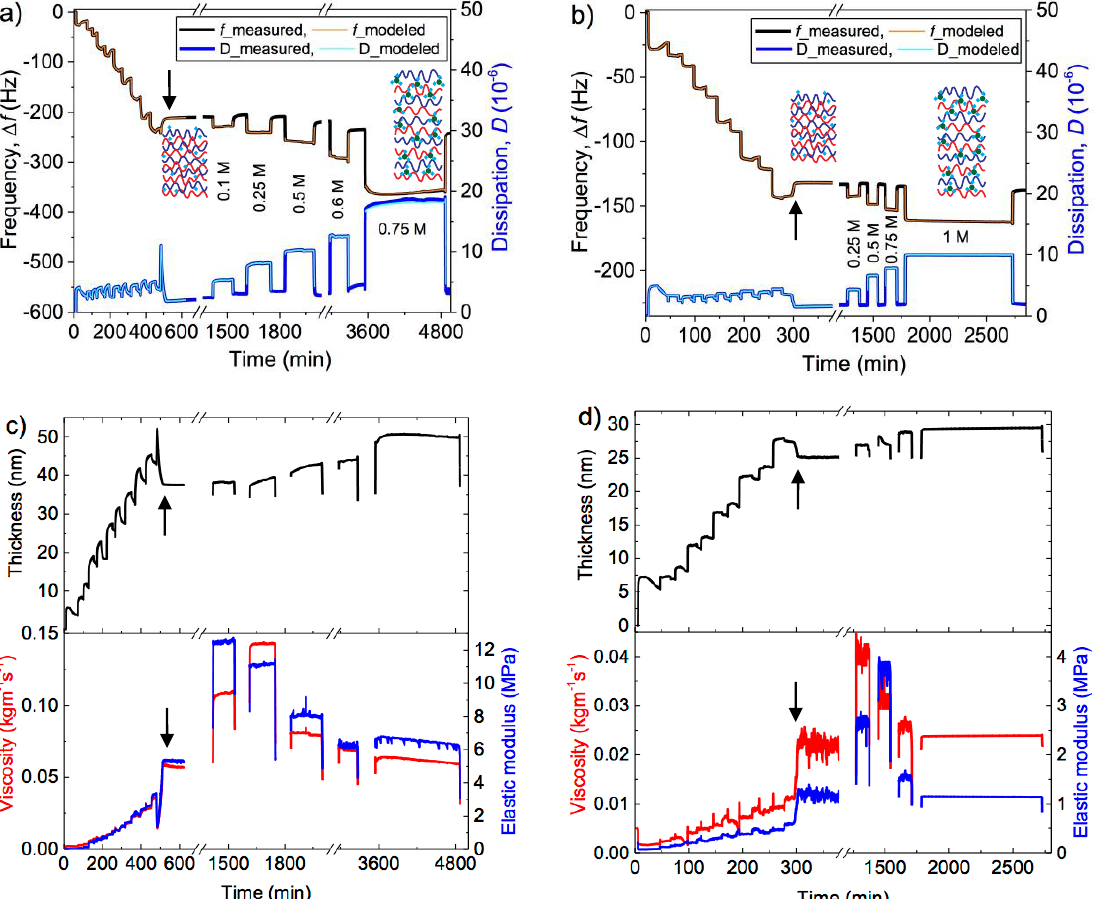
Figure 2. Measured and modeled QCM-D frequency and dissipation shift (7th overtone) upon assembly of ( a ) PEI(PSS/PDADMAC) 4 PSS and ( b ) PEI(PSS/PAH) 4 PSS and their subsequent swelling with the EMIM solution at the EMIM concentrations indicated. Modeled thickness, viscosity and elastic modulus upon layer assembly and subsequent swelling of ( c ) PEI(PSS/PDADMAC) 4 PSS and ( d ) PEI(PSS/PAH) 4 PSS multilayers. The arrows indicate the end of the assembly, where flushing with pure water was performed, followed by the salt swelling cycles. Note that only one representative overtone is displayed, while 5 different overtones were employed in a global fit. Table 2. The average thickness, viscosity and elastic modulus of hydrated PEI(PSS/PADMAC) 4 PSS and PEI(PSS/PAH) 4 PSS multilayers obtained from the Kelvin-Voigt modeling.